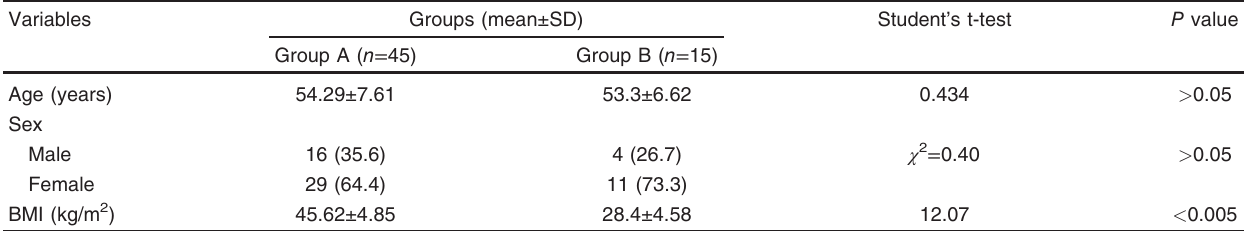
Table 1 Comparison between group A and group B regarding age, sex, and BMI